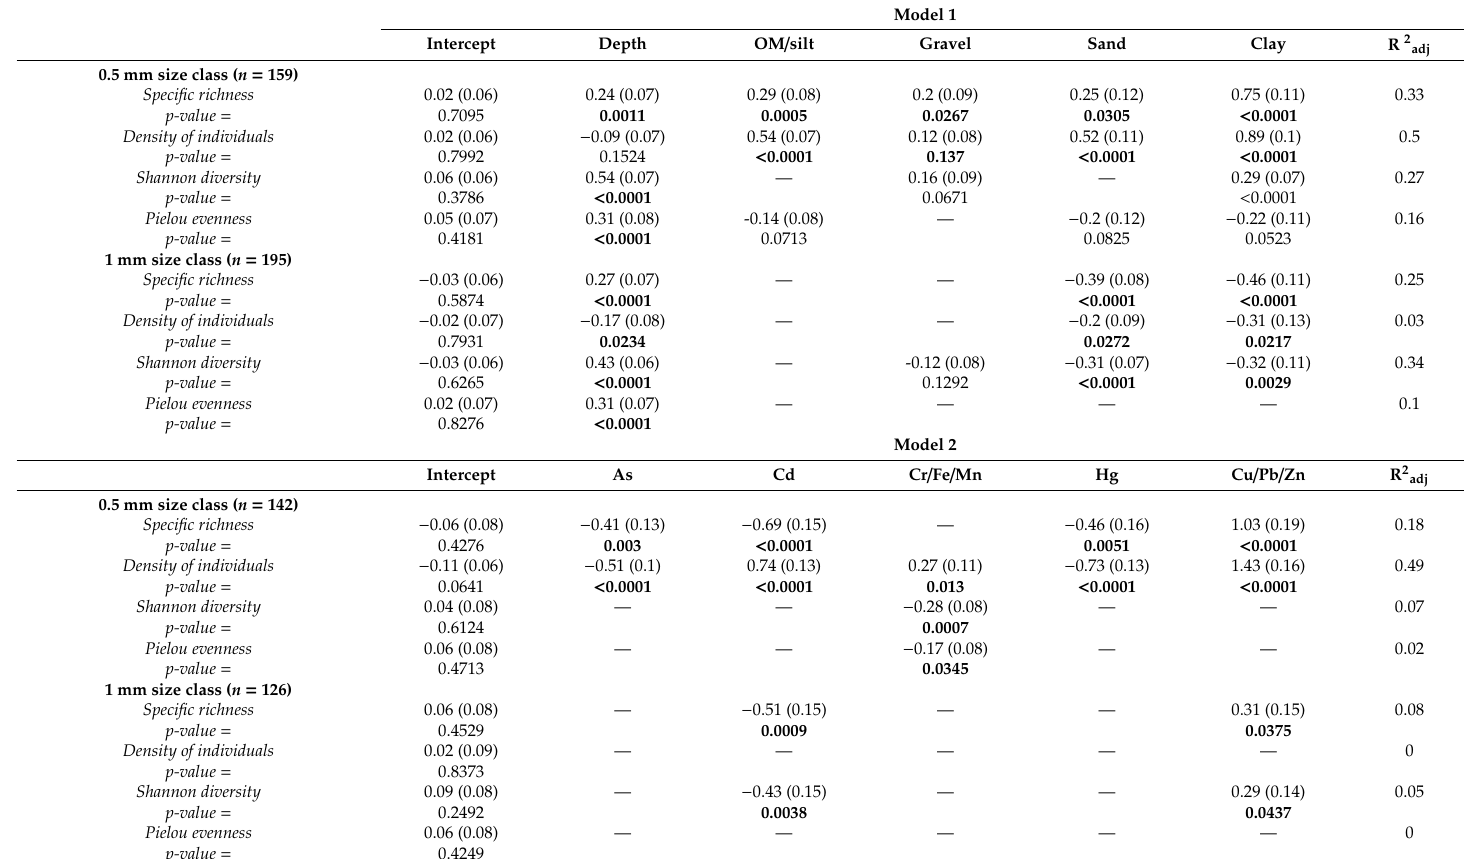
Table 2. Predictor coe ffi cients (and standard error) from the multiple linear regression models of community characteristics obtained for the 0.5 mm and the 1 mm size classes. Model 1 corresponds to organic matter and grain size classes as predictors for stations in every sector, and Model 2 corresponds to heavy metal concentrations as predictors for stations in Baie des Sept Îles only. OM = organic matter, As = arsenic, Cd = cadmium, Cr = chromium, Cu = copper, Fe = iron, Mn = manganese, Hg = mercury, Pb = lead, Zn = zinc, n = number of stations considered, “—” = predictors excluded by the best fit model selection. Significant p -values of marginal tests on predictors are highlighted in